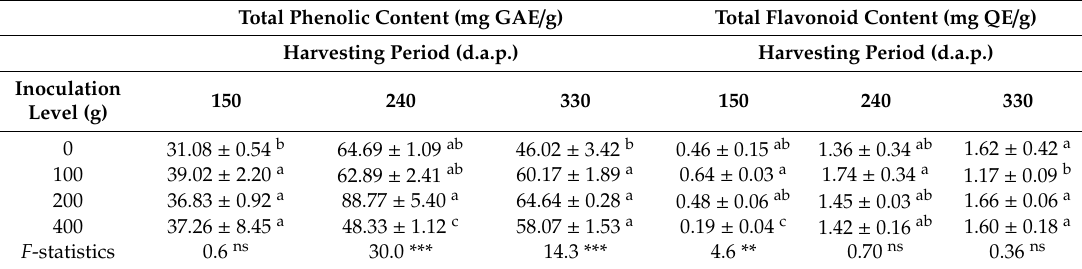
Table 2. Accumulation of total phenolics and total flavonoid contents responds to four rhizobium inoculation levels and di ff erent harvesting periods of L. frutescens